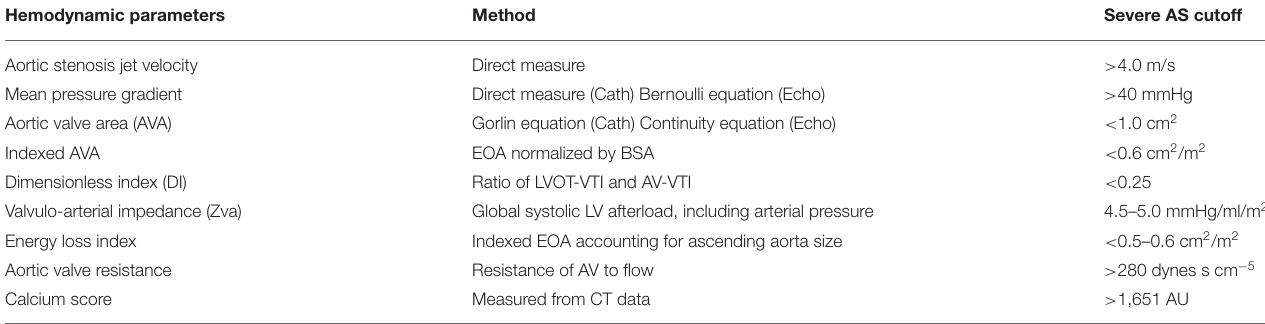
TABLE 1 | Hemodynamic parameters for assessment of aortic stenosis and their cutoff values for severe aortic stenosis. Hemodynamic parameters